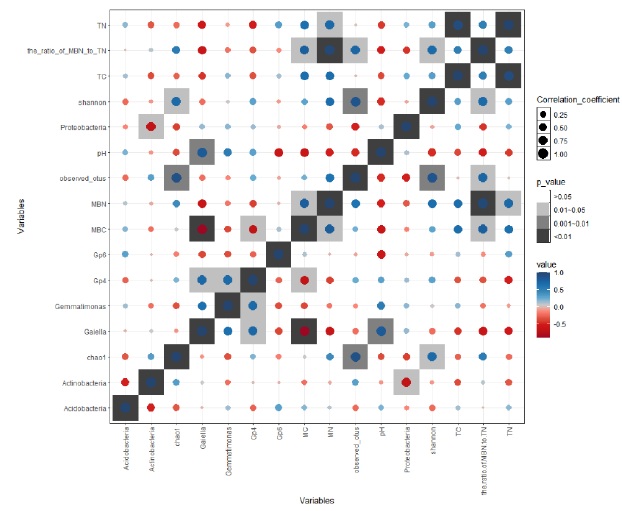
Figure 5. Analysis of correlation between the soil properties and soil bacterial communities.